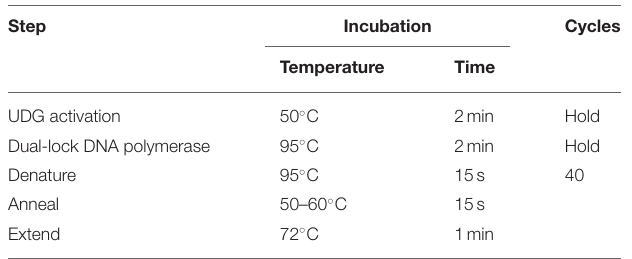
TABLE 2 | Cycling mode of Sutterella spp. according to primer melt temperature (30).